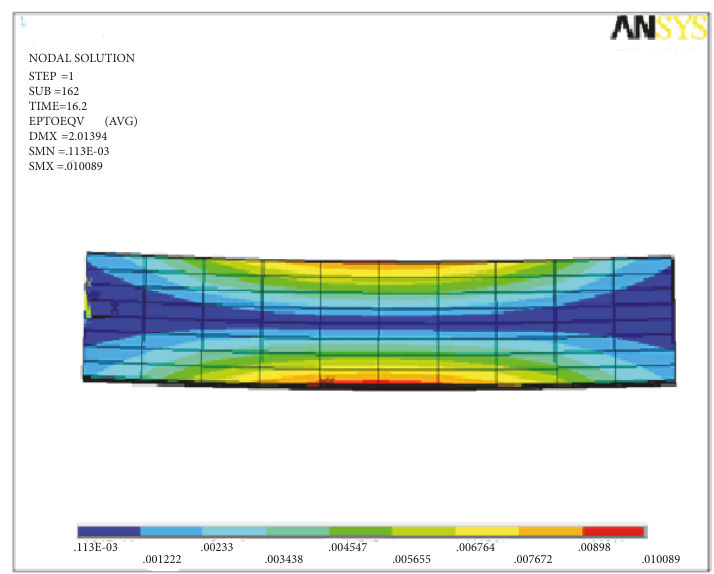
Figure 5: Elastic limited state analyzed by ANSYS.